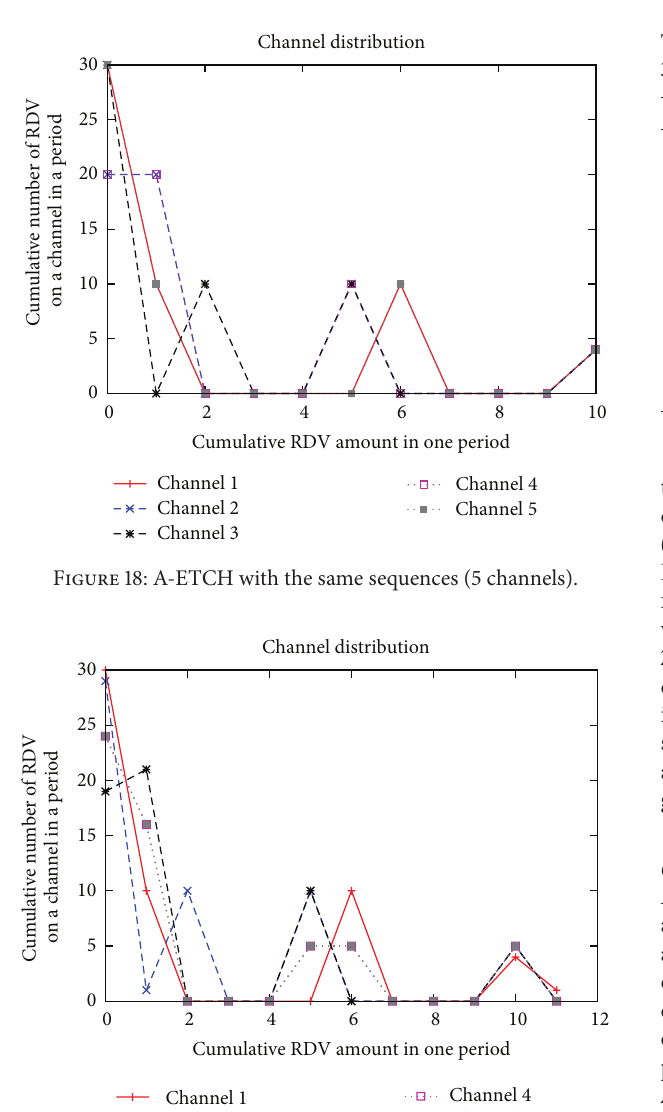
( ∗∗ ) is about selection of